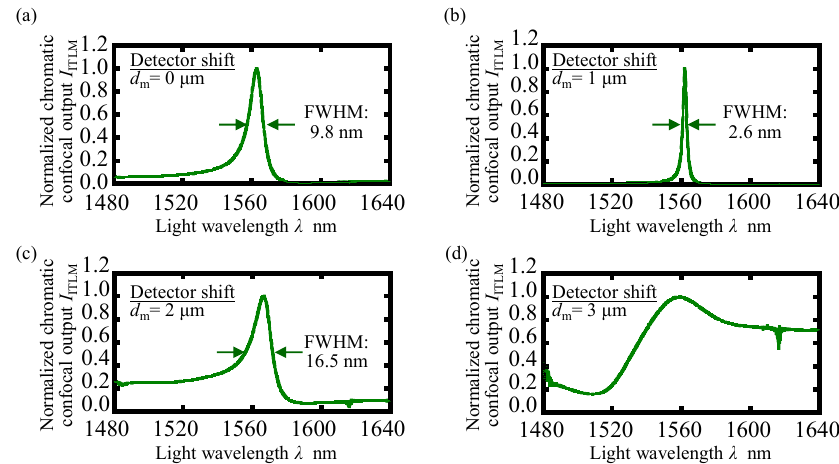
Figure 10. Normalized chromatic confocal output at each off-axis displacement d m of the fiber detector in the reference detector. ( a ) d m = 0 μ m; ( b ) d m = 1.0 μ m; ( c ) d m = 2.0 μ m; ( d ) d m = 3.0 μ m.